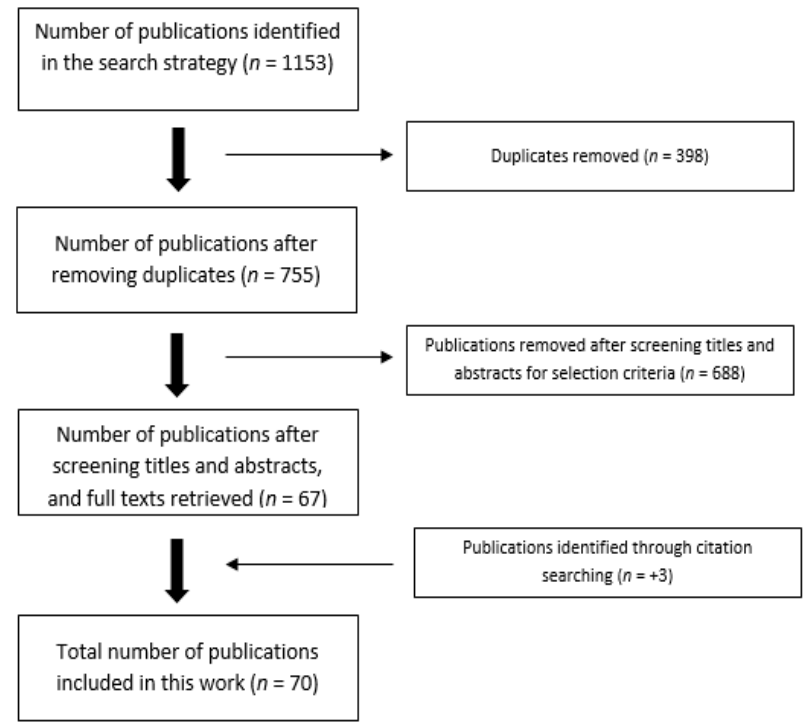
Figure 1. Flowchart for the selection of publications for systematic review and meta-analysis.